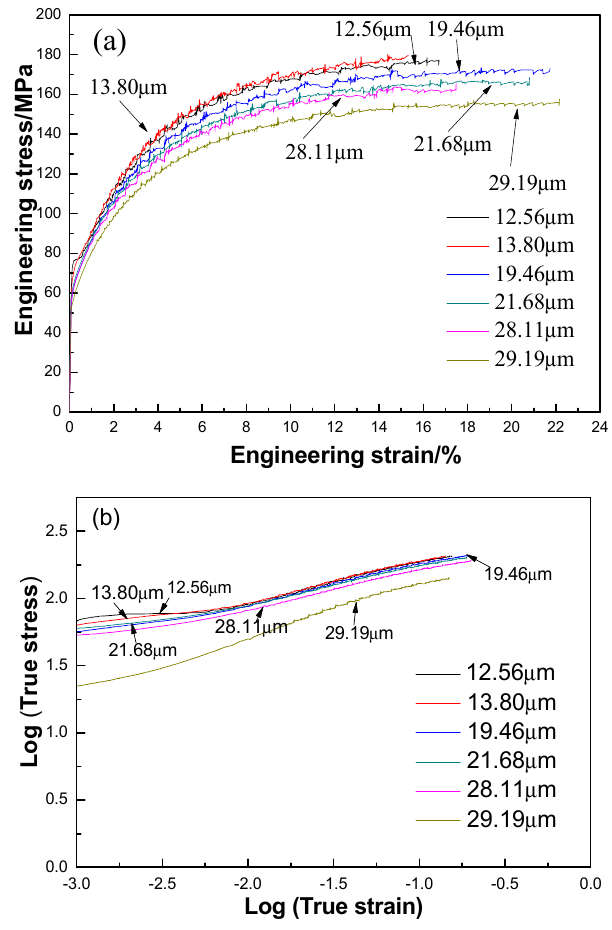
Figure 5. Complete typical engineering strain-engineering stress ( a ) and uniform plastic deformation part of log (true strain)-log (true stress) ( b ) curves of 3104 sheets with different grain size.